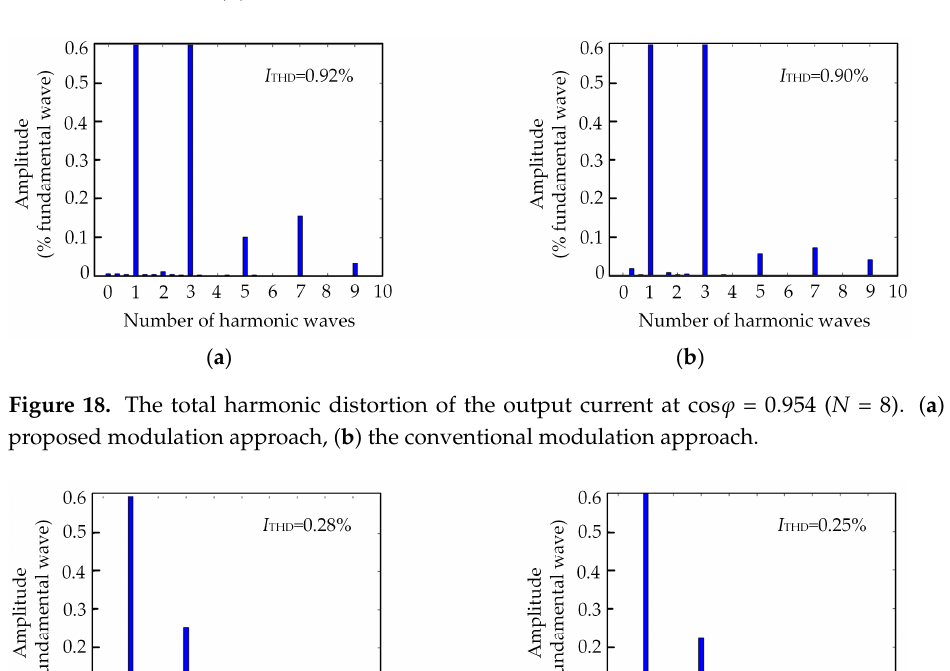
Figure 17. Experimental output waveforms of the converter at cos φ = 0.623 ( N = 8). ( a ) The proposed modulation method, ( b ) the conventional modulation method.